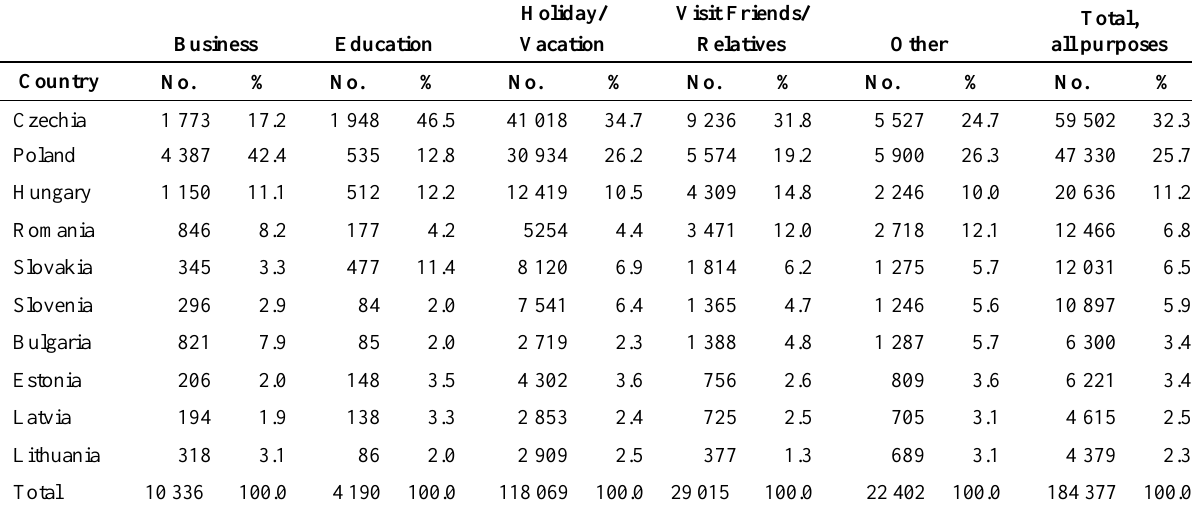
Table 1. Visitor arrivals by purpose, CEE EU-10 nationals,